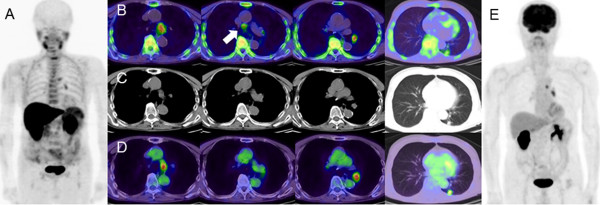
4DST MIP (A), 4DST axial (B), CT (C), FDG axial (D), and FDG MIP images (E). PET images (axial and maximum-intensity-projection) with 4DST and FDG for lymph node lesions and the primary lung cancer in patient No. 23. The background uptake is clearly lower in 4DST than FDG. 4DST and FDG show intense uptake at the left lower paratracheal lymph node (#4 L) and the left hilar lymph node. 4DST also shows uptake at the lower paratracheal lymph node (arrow), not clearly identified on FDG.